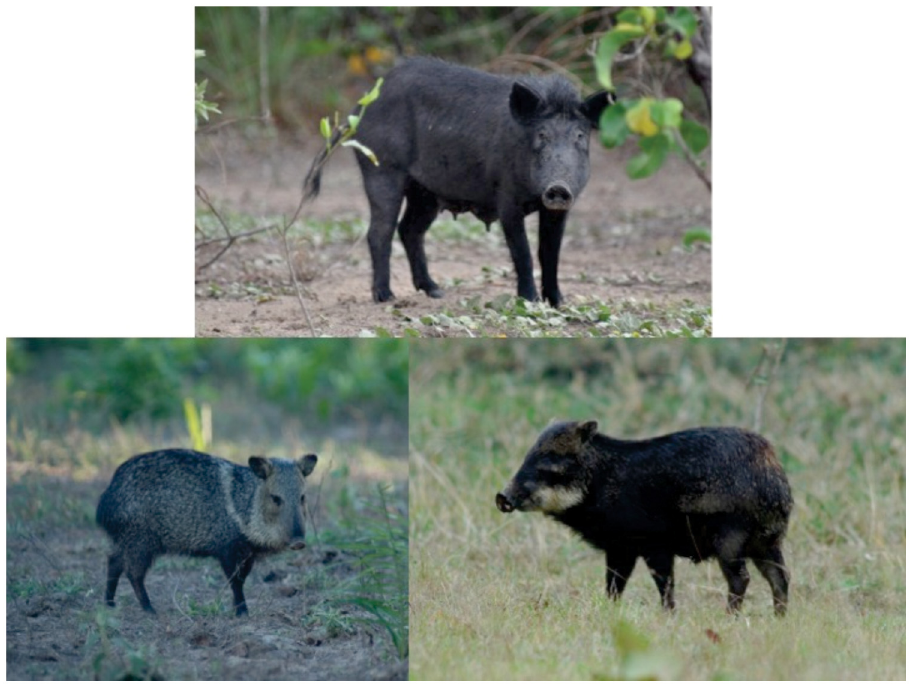
Fig 1. Feral pigs ( Sus scrofa ) (Upper center), collared peccaries ( Pecari tajacu ) (Botton left) and white- lipped peccaries ( Tayassu pecari ) (Botton right) in the Brazilian